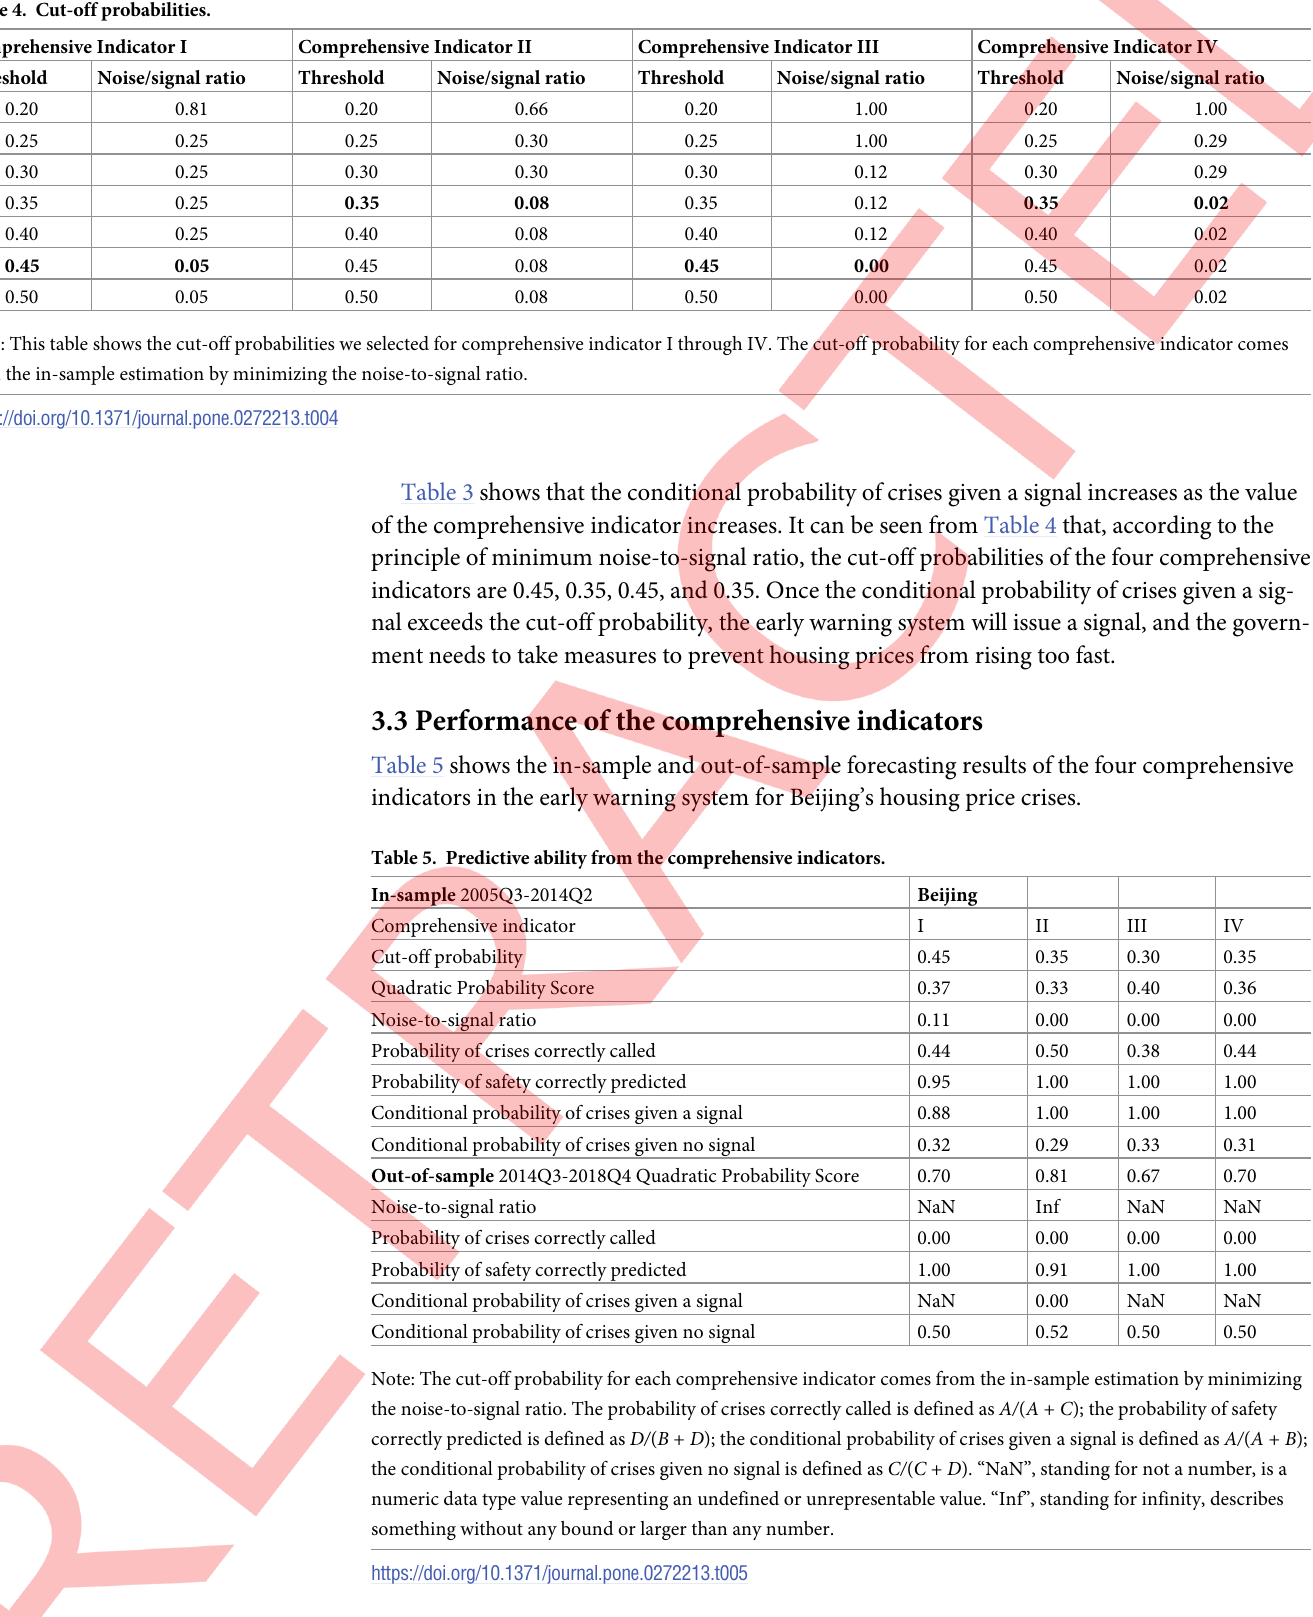
Table 4. Cut-off probabilities.